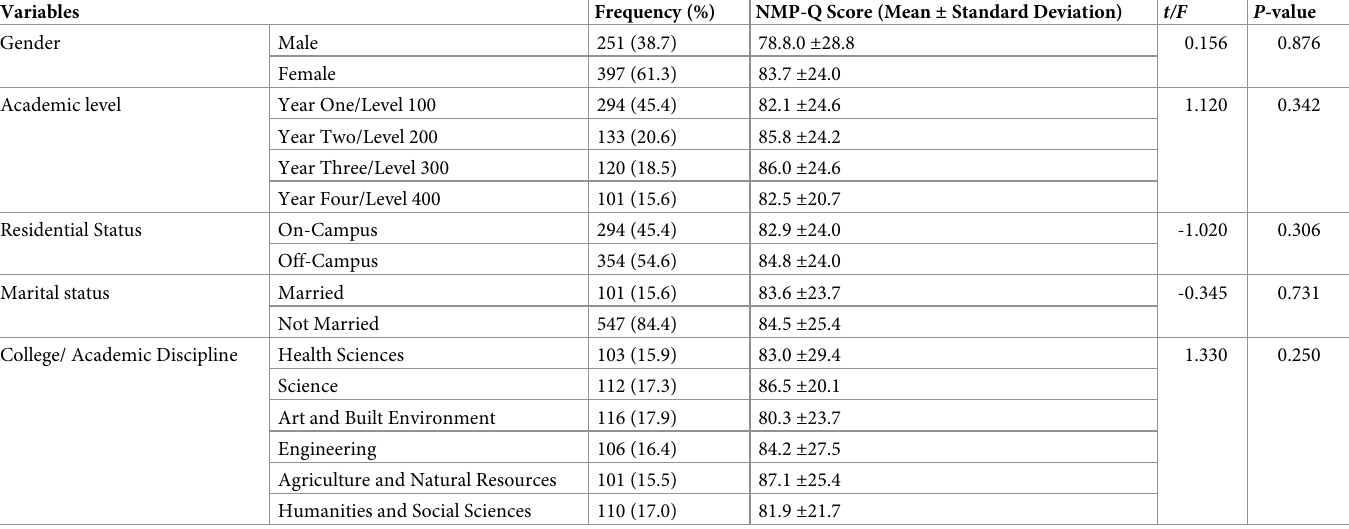
Table 7. Distribution of sociodemographic profiles of the students ( N = 670 ) and their nomophobia scores.